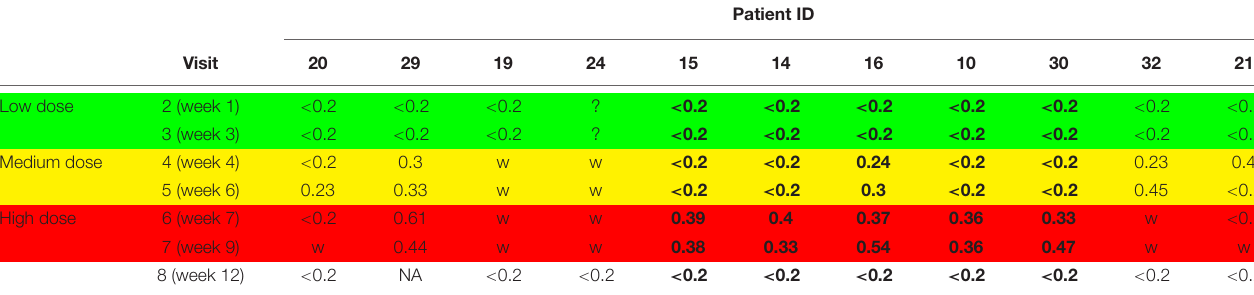
TABLE 3 | Plasma lithium level (mmoles/l) during stepwise increase in lithium dose in